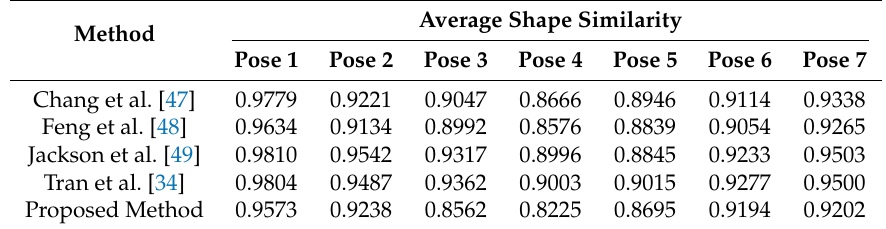
Table 5. Comparison results with other state-of-the-art deep learning-based approaches using the Morphace datasets. The average shape similarity of 100 subjects under each